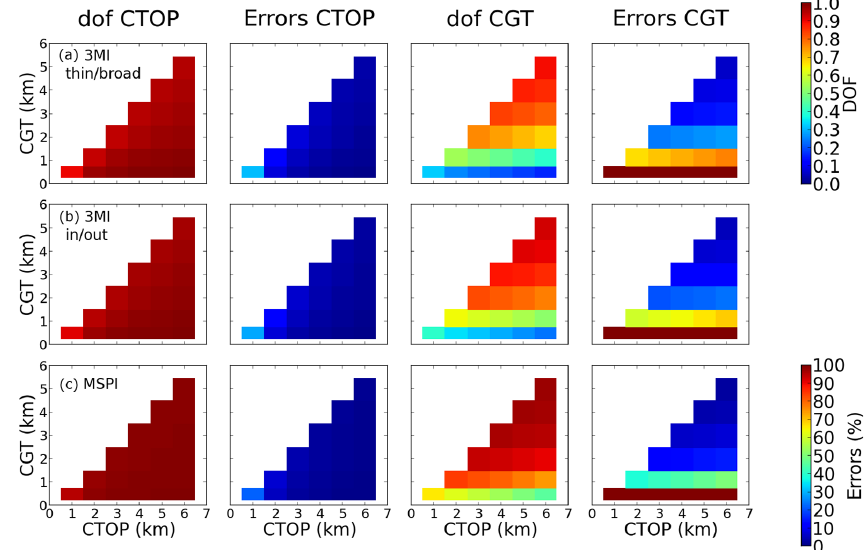
Figure 11. 3MI/MSPI information content comparison. Partial DOFs and a posteriori errors of the A-band of (a) 3MI with the configuration using thin band on broadband, (b) 3MI with the in-band on out-band method and (c) MSPI, using the in-band on out-band method with a different filter and 9 view angles instead of 14 for 3MI. COT = 16, r eff = 12µm, v eff = 0.02, SZA = 30 ◦ , orbit/AS